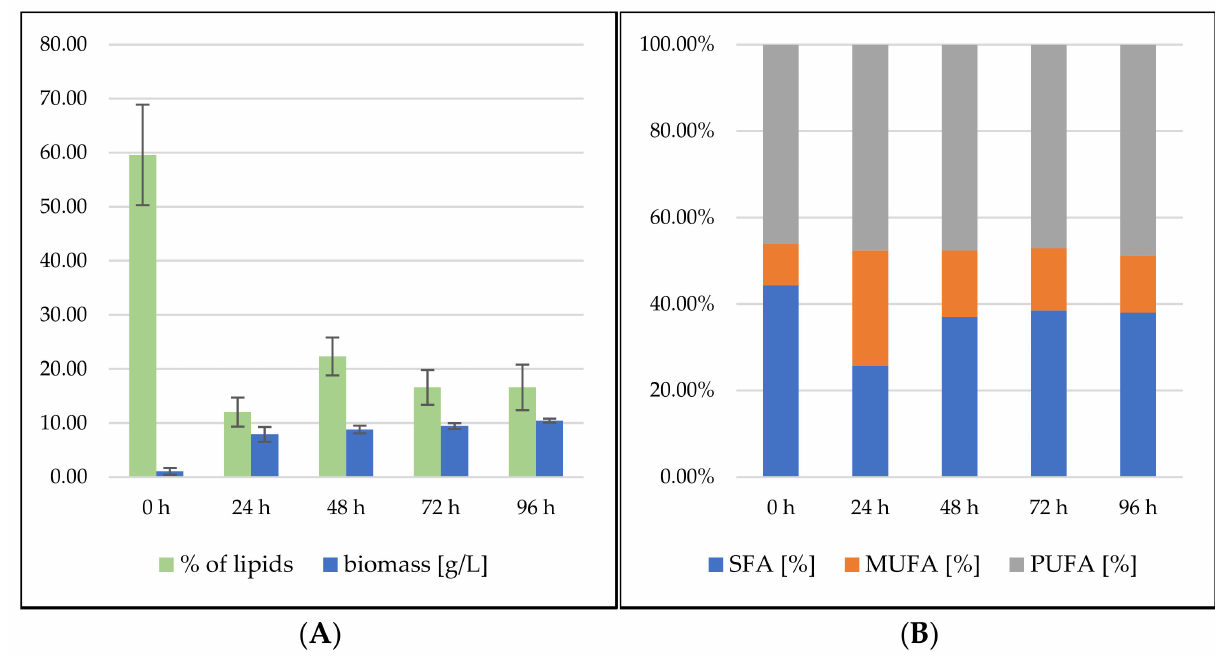
Figure 6. Rhodosporidium toruloides bioreactor cultivation on SCG hydrolysate + coffee oil. ( A ) Biomass production (g/L) and total lipid production (%); ( B ) Fatty acid profile